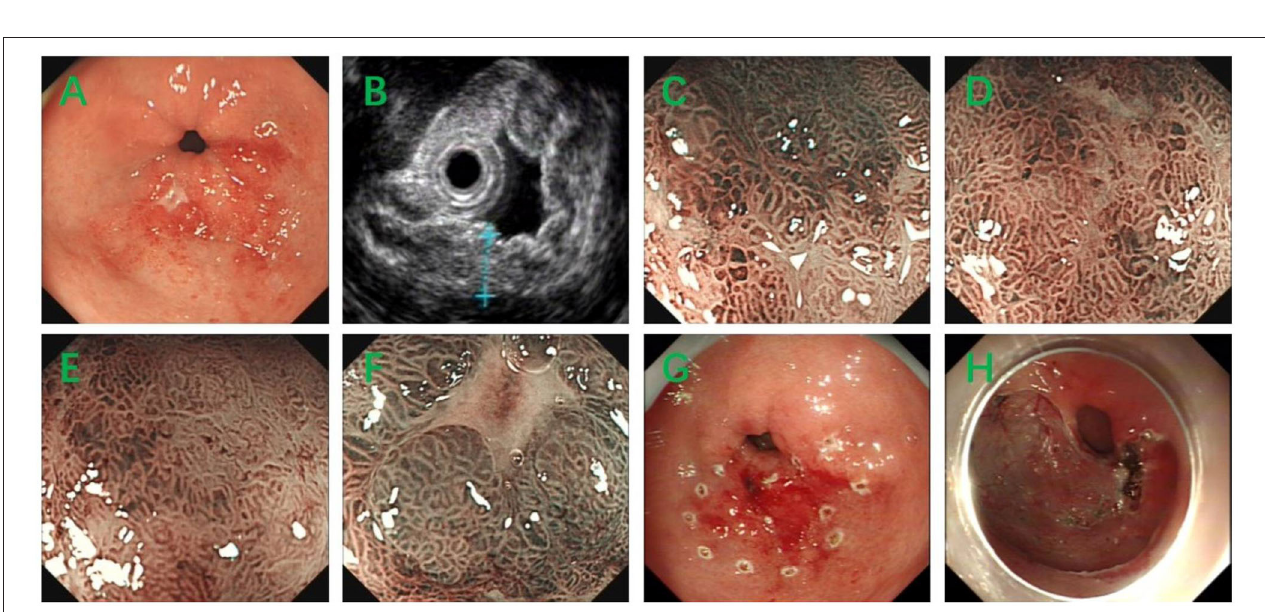
FIGURE 4 | (A) Gastroscopy revealed erosion and ulcer in greater curvature of gastric antrum. (B) EUS revealed a hypoechoic lesion from mucosa layer, muscularis mucosa layer, and submucosa layer. (C–F) ME-NBI showed irregular marginal crypt epithelium and subepithelial capillary network. (G,H) The procedure of ESD.